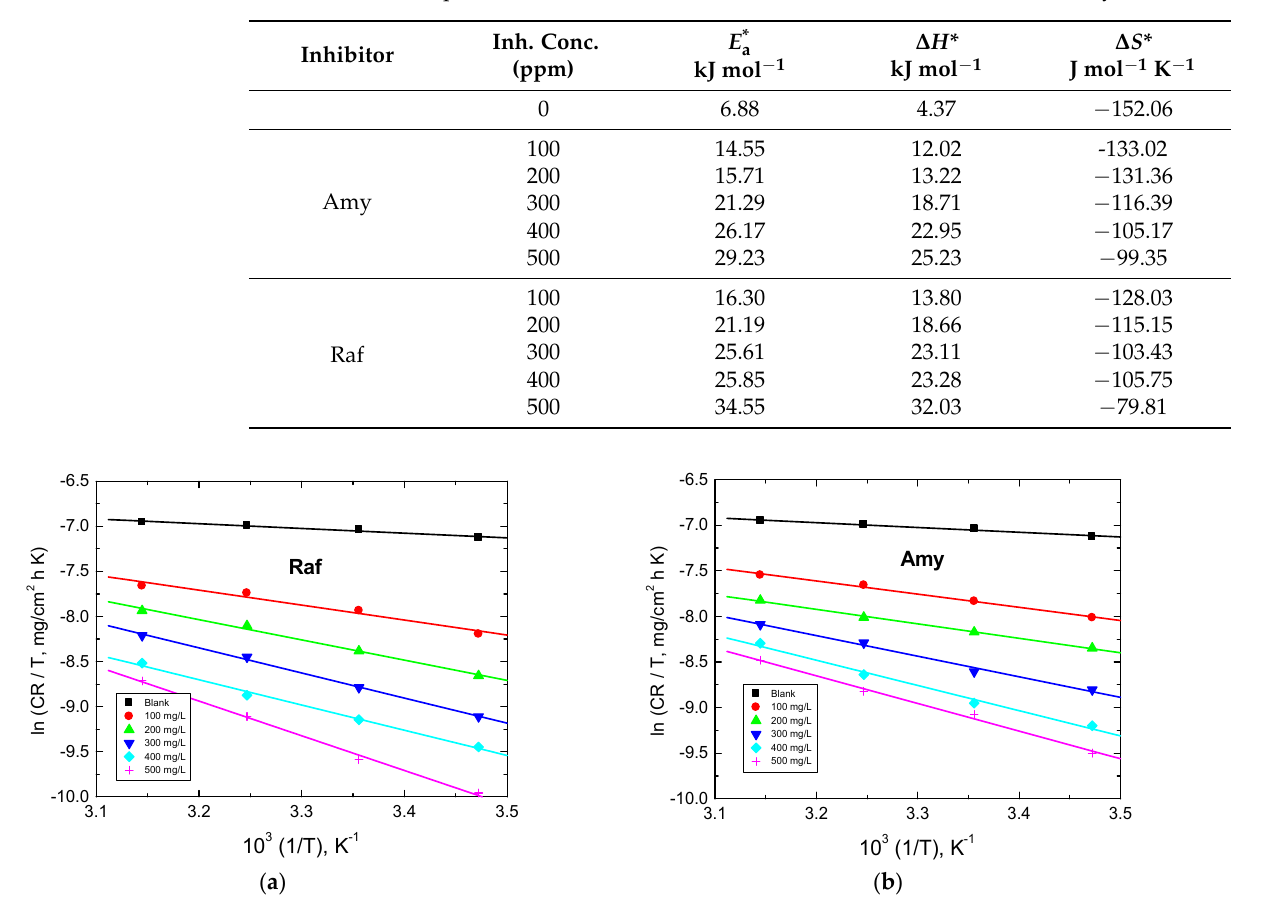
Figure 12. Transition ‐ state plots for Al corrosion in 0.1 M NaOH medium and with, ( a ) Amygdalin (Amy), and ( b ) Raffinose (Raf). Table 6. Activation parameters for Al corrosion in 0.1 M NaOH medium and with Amy and Raf. Inhibitor Inh. Conc. (ppm)